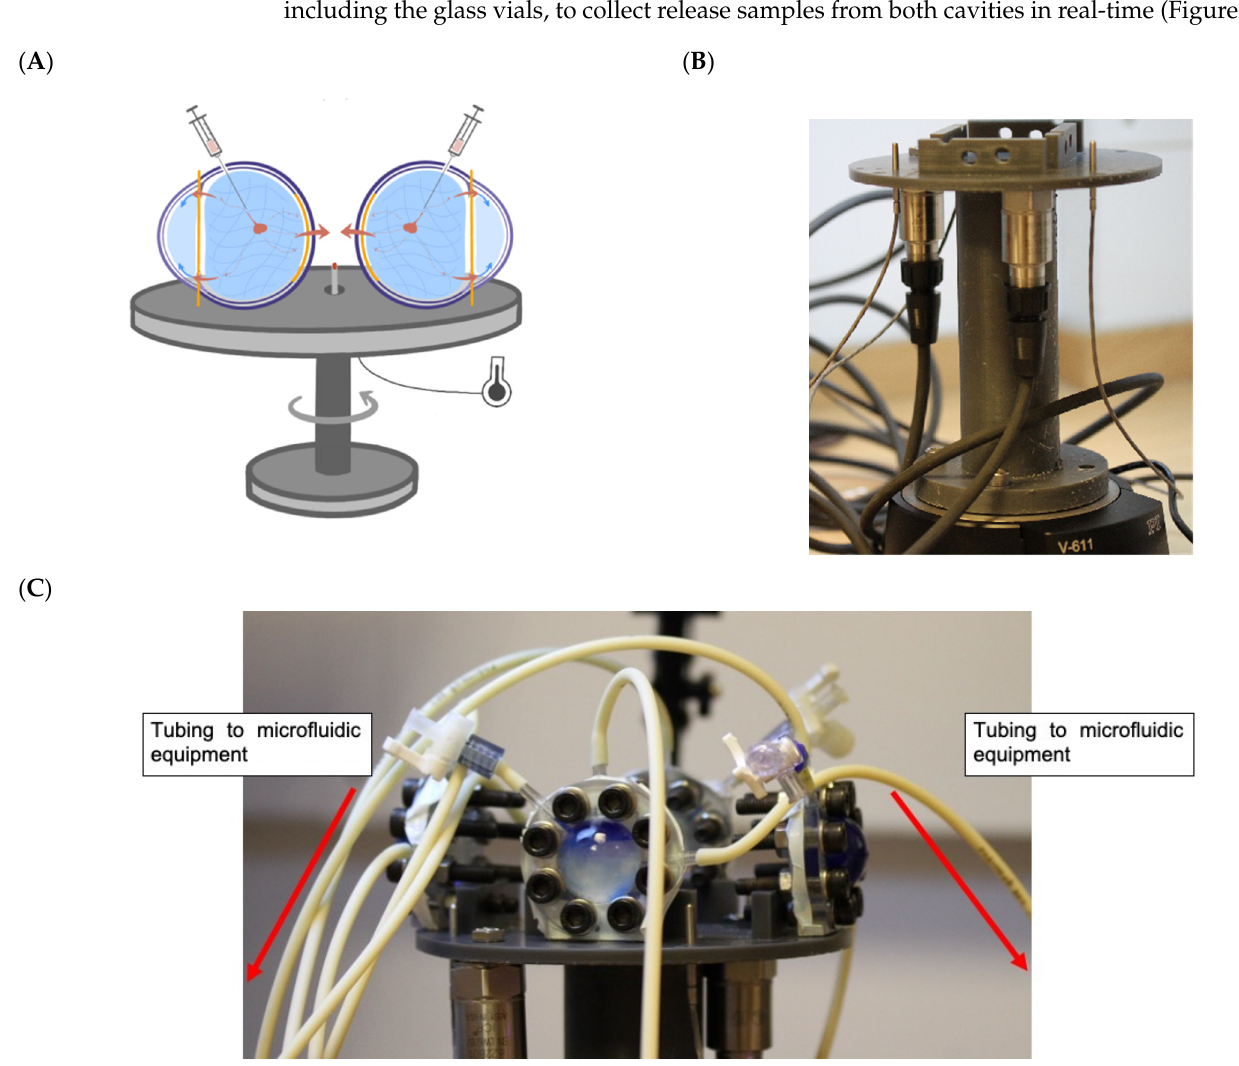
Figure 3. ( A ) Schematic of the PK-Eye™ mounted on the rotating platform and ( B ) V-611 rotational stage and ( C ) 3D-printed eye movement platform to hold PK-Eye™ models with collector vials, and grooves to place collector vials from TM and RCS outflow pathways.